Question: In one sentence, what is this figure communicating?
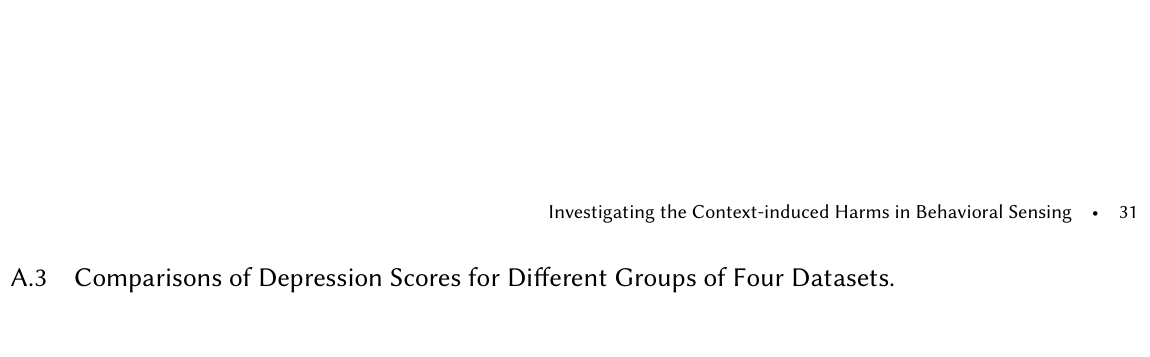
Answer: Comparisons of depression (BDI-II) scores for different groups of four datasets. The red dotted line indicates the cutoff point (i.e., 13) for BDI-II scores, which is used to distinguish between students with at least mild depressive symptoms (BDI-II score >=13) and those without (BDI-II < 13). Significance levels after Benjamini-Hochberg (B-H) correction are marked with an asterisk (*𝑝< 0.05) in red on the subplot. First-gen, BA, and HET represent first-generation college students, bachelor, and heterosexual, respectively.